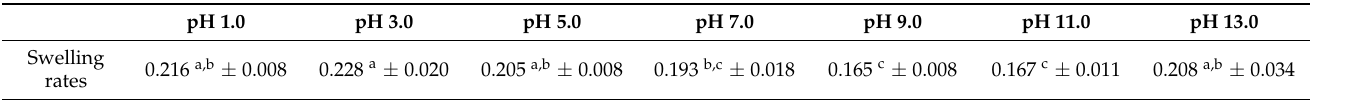
Table 2. Swelling properties of MRCM in different pH solutions.